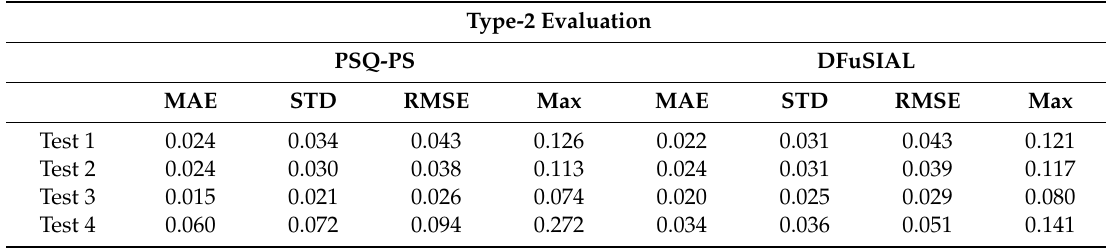
Table 3. Type-2 evaluation of fraction values, obtained in Experiment 1 (Tests 1-4) by PSQ-PS and the proposed fusion method DFuSIAL, with respect to the obtained fractions, in LSR by SUnSAL.